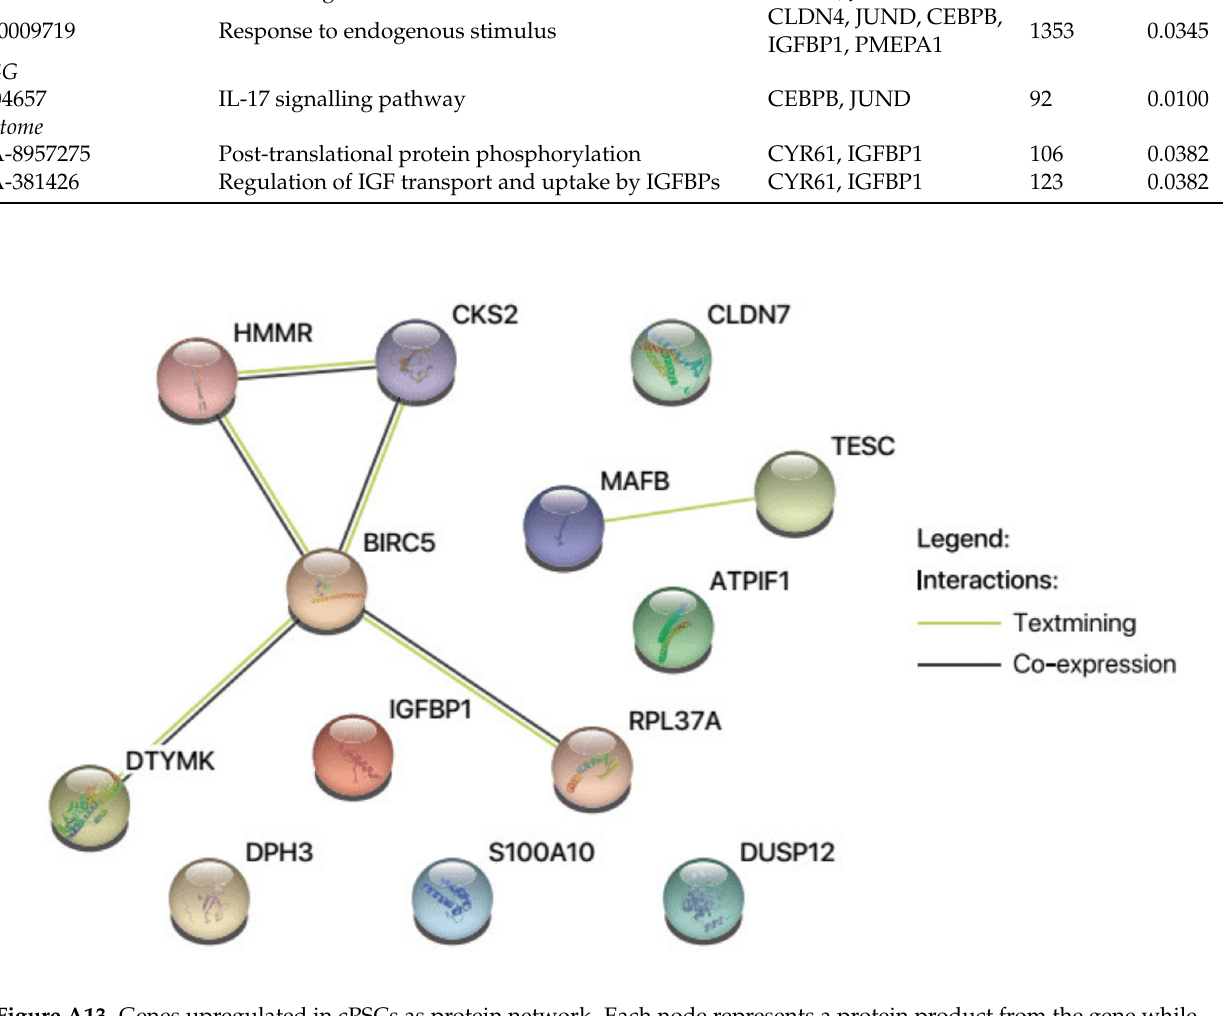
Figure A13. Genes upregulated in cPSCs as protein network. Each node represents a protein product from the gene while the edges represent interactions between these proteins. Overall interaction enrichment p -Value was 0.00144, suggesting this group of over-expressed genes are likely to be biologically